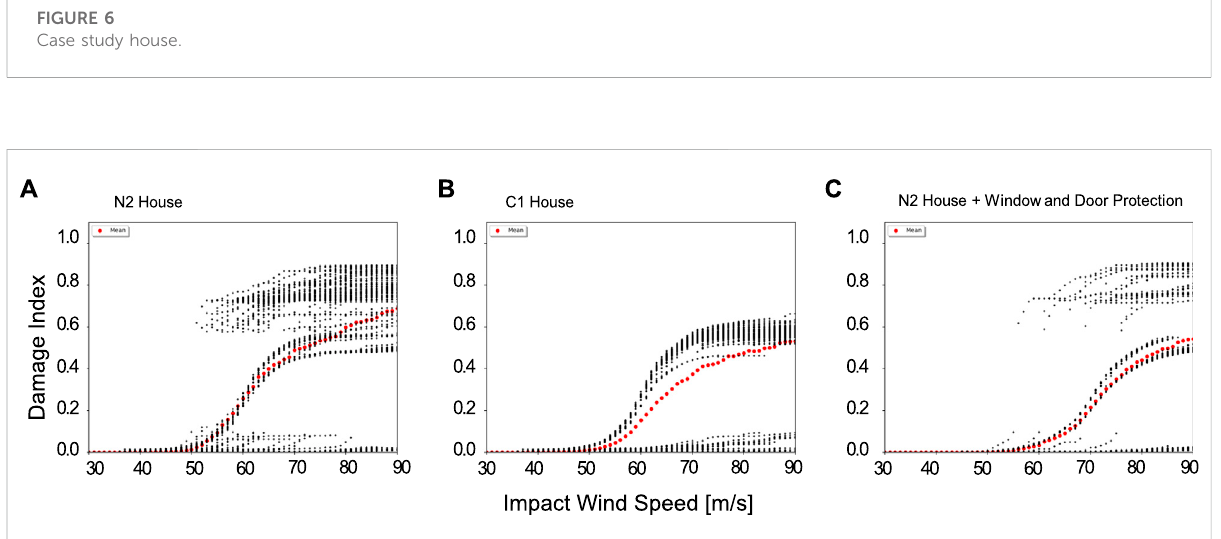
FIGURE 7 Vulnerability functions generated by the VAWS software for the case study house. (A) for an N2 wind rated house, (B) for a C1 wind rated house and (C) for a N2 wind rated house with window and door protection.